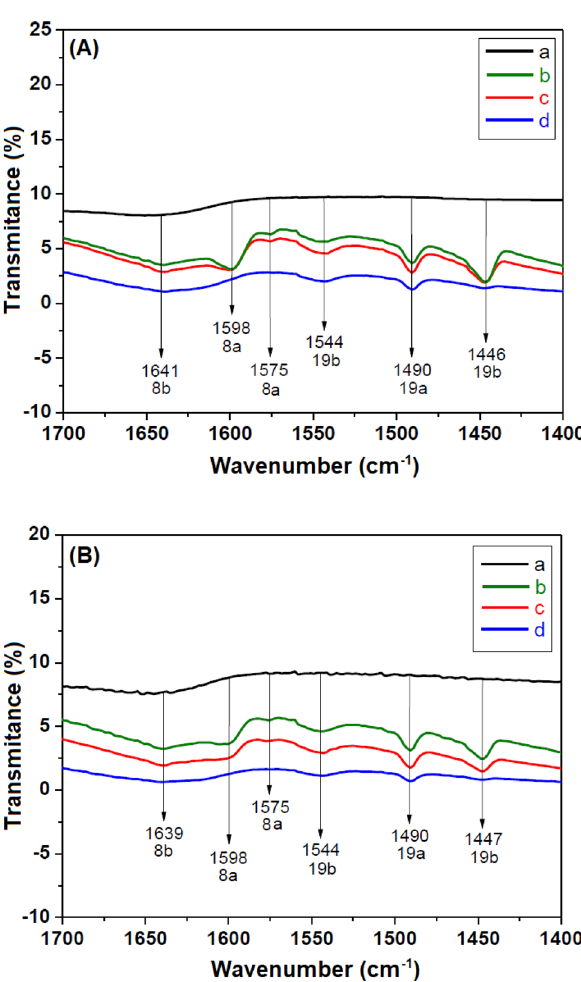
Figure 10. Infrared spectra of pyridine adsorbed on SiTiNb-A (A) and SiTiNb-B (B ) at different temperatures under vacuum: (a) pure SiTiNb, (b) room temperature, ( c ) 373 K, ( d ) 423